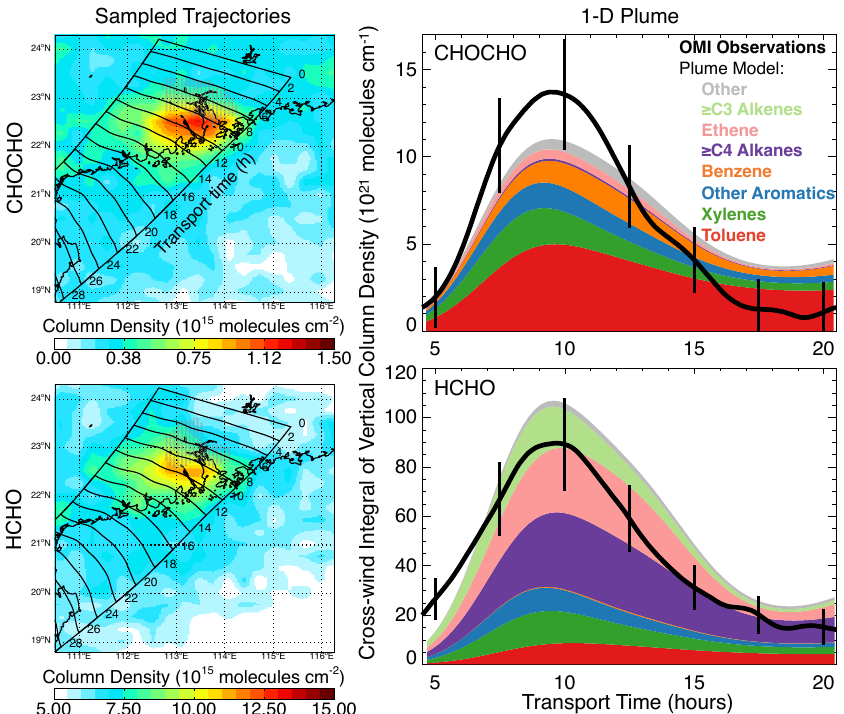
Figure 4. Mean CHOCHO and HCHO PRD plumes under northeasterly flow conditions. Left: vertical column densities, overlaid with surface air (60m) trajectories for the mean wind field of Fig. 3. The trajectories are initialized upwind of the PRD ( t = 0), and transport times in hours along the trajectories are indicated. The grey hatched area indicates the location of maximum emissions as diagnosed by the peak concentrations for the calm wind conditions in Fig. 3 (8 × 10 14 and 1 . 25 × 10 16 moleculescm − 2 for CHOCHO and HCHO, respectively). Right: CHOCHO and HCHO cross-wind integrals of vertical column density. The OMI observations are line integrals across the trajectories in the left panels, and vertical bars are retrieval uncertainties. The stacked contours are results from the 1-D plume model showing the contributions from individual VOCs as given by the Zheng et al. (2009a) PRD inventory, combined with the CHOCHO and HCHO yields of Fig. 2. VOC emissions in the plume model for CHOCHO and HCHO are centered at transport time t = 6 . 5 and t = 7 . 0h, respectively, based on the plume location during calm wind